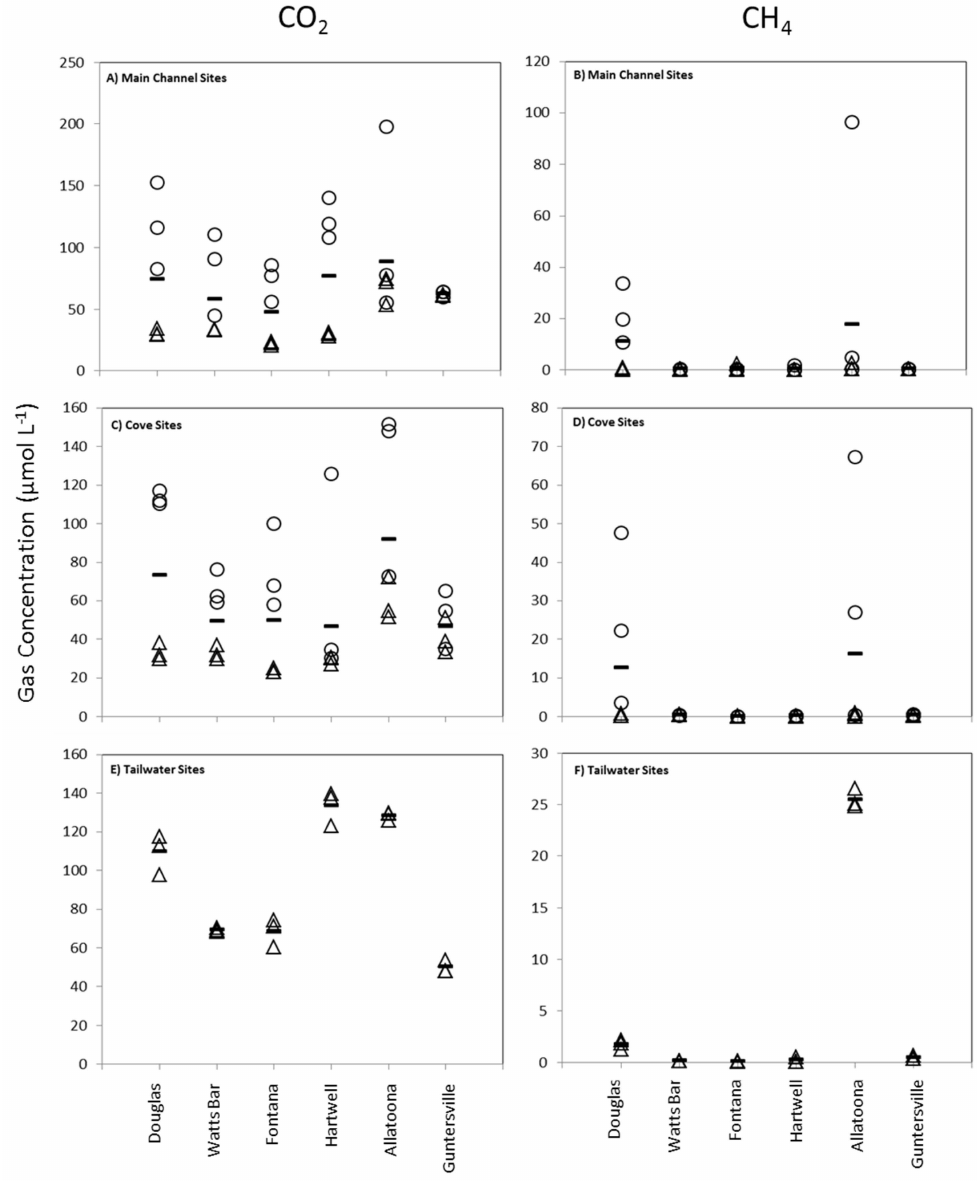
Figure 4. Concentrations ( µ mol ¨ L ´ 1 ) of CO 2 and CH 4 from water samples collected from main channel ( A , B ), cove ( C , D ), and tailwater sites ( E , F ) at six reservoirs. Triangles represent samples from the surface (1 m depth) and circles represent samples collected 1 m above the bottom. Mean values are indicated with a